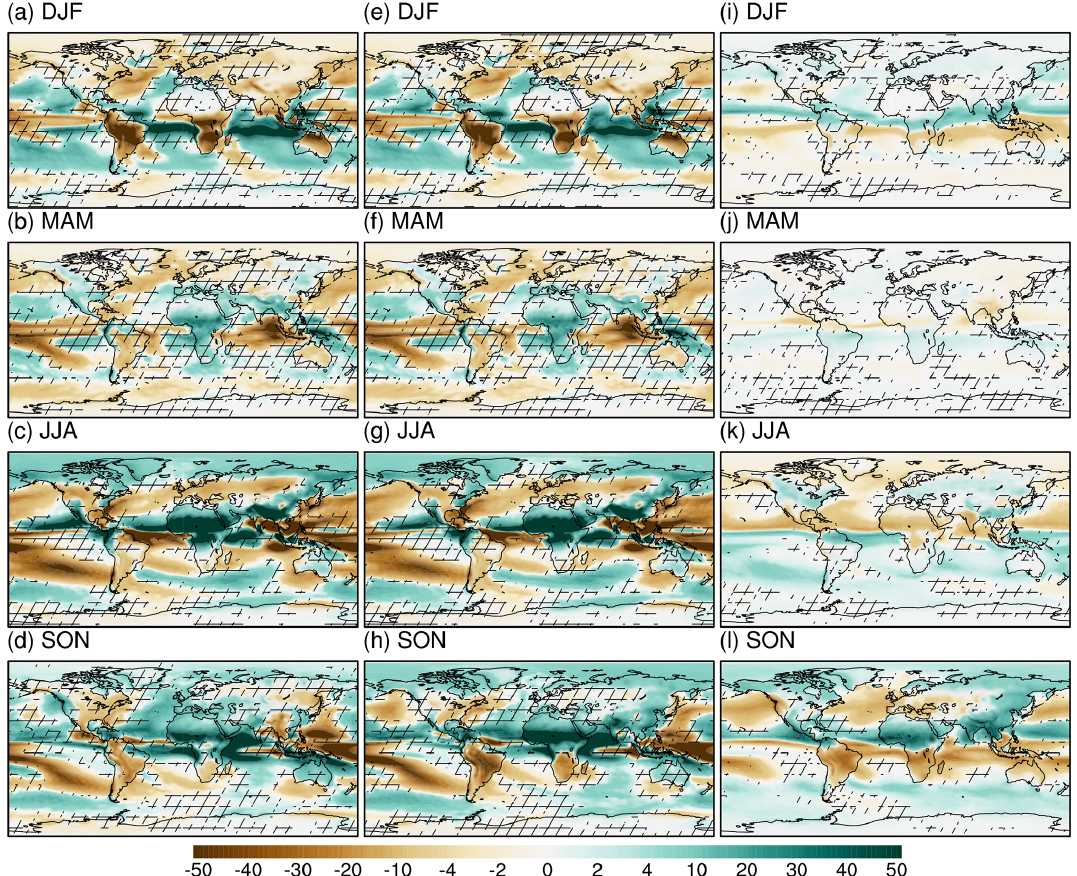
Figure 7. Ensemble precipitation for (a–d) LIG minus PI classical means, (e–h) LIG minus PI angular means, and (i–l) anomalies between LIG minus PI classical means and LIG minus PI angular means. The unmarked area indicates that at least seven models show the same sign. Units: mm per